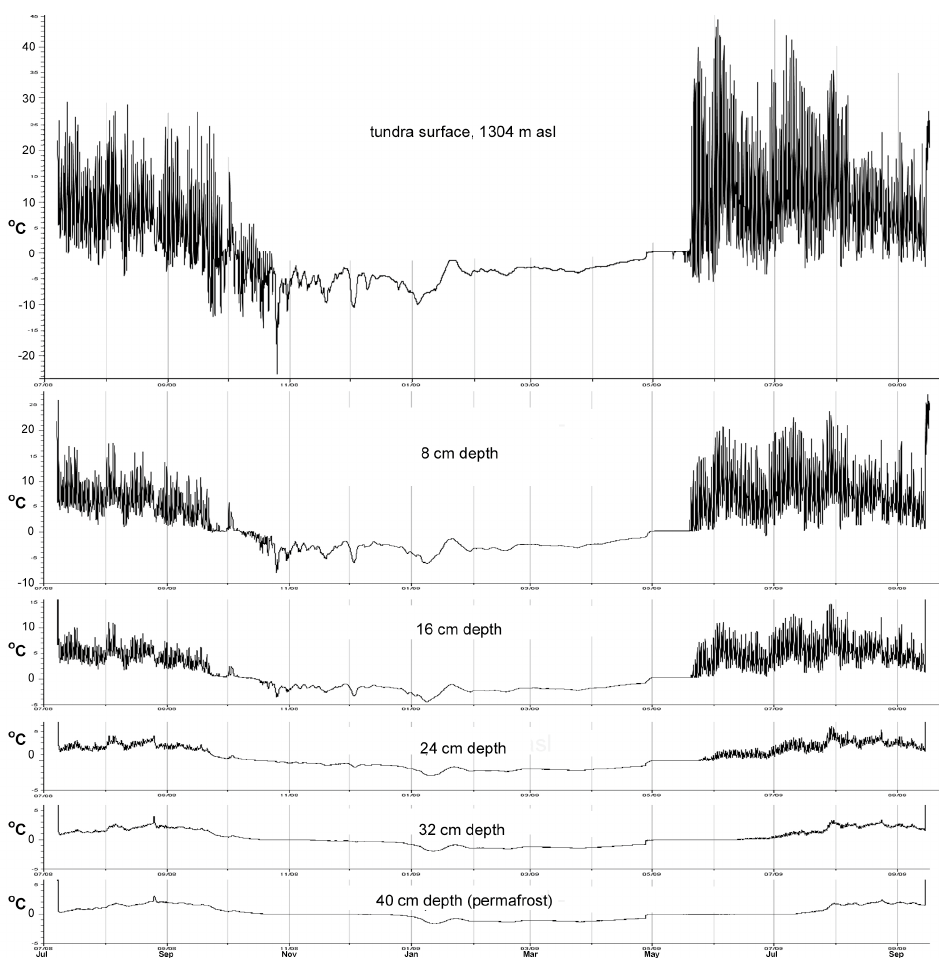
Figure 7. July 2008 to September 2009 variation in soil temperature at the surface and five successive depths spaced 8 cm apart, the 40 cm depth being just above the permafrost table. Data were gathered using Hobo UA-002-64 light/temperature data loggers. Light data were used to confirm that the loggers remained